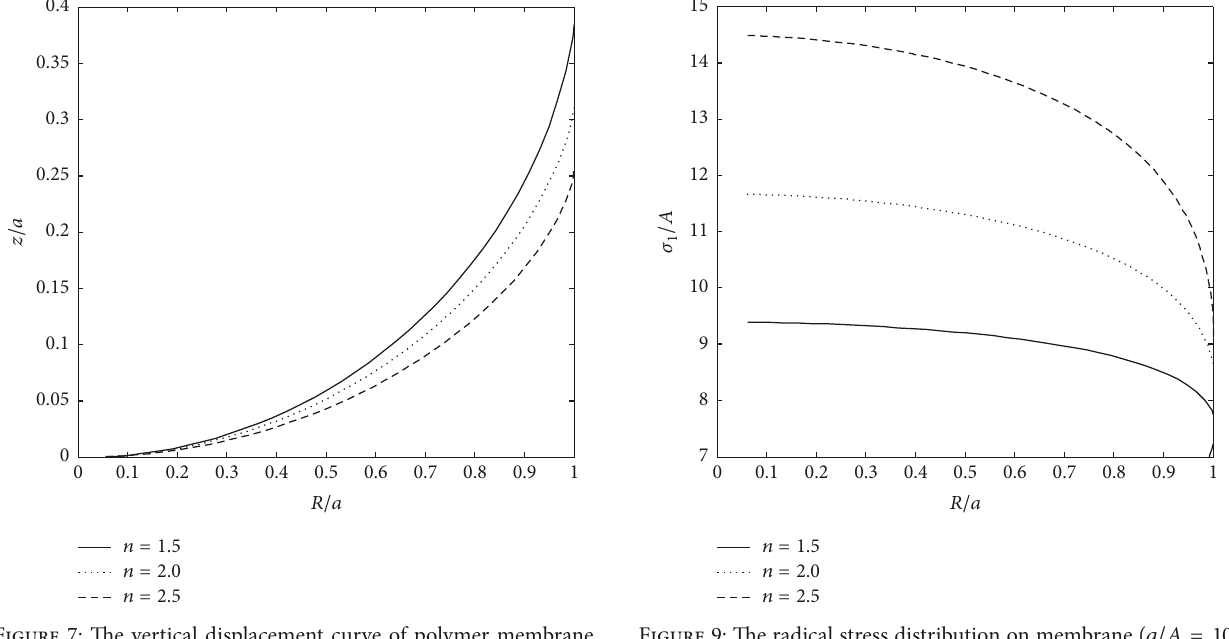
Figure 7: The vertical displacement curve of polymer membrane ( 𝑞/𝐴 = 10 ; 𝛼 = 0.6 ).